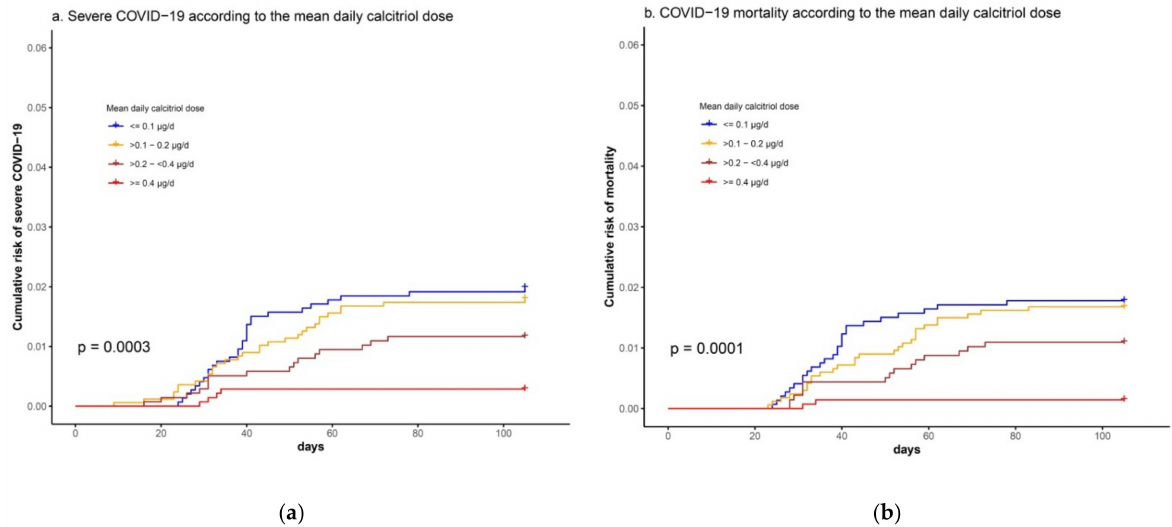
Figure 3. Kaplan–Meier plots showing ( a ) cumulative risk of severe COVID-19 (composite outcome of need for non-invasive mechanical ventilation, orotracheal intubation, mechanical ventilation, intensive care unit admission or COVID-19 mortality) between 25 February 2020 and 7 June 2020, according to the calcitriol dose being supplied (by quartiles); ( b ) COVID-19 mortality during the same period, according to the calcitriol dose being supplied (by